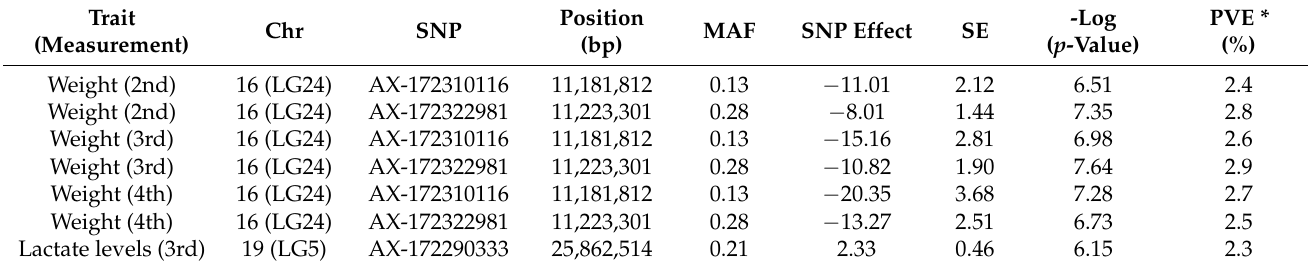
Table 6. Significant SNPs in batch 10 from univariate GWAS.